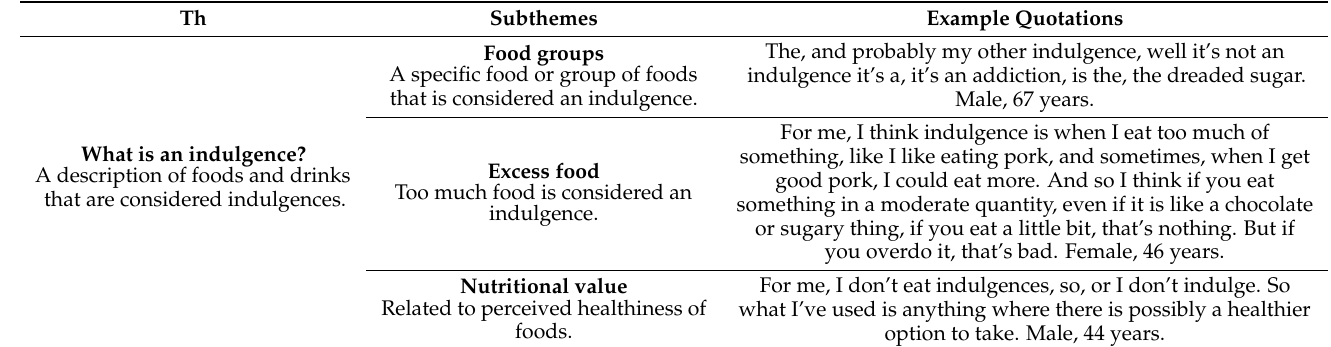
Figure 1. An overview of the factors affecting the consumption of indulgences and the strategies used to reduce consumption. Table 1. Thematic map summarising themes generated from participant